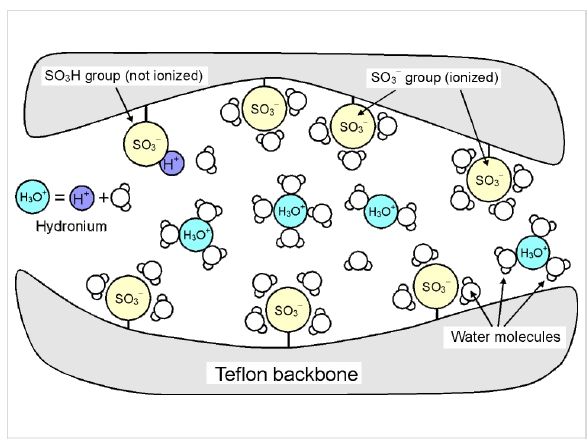
Figure 1: Illustration of the proton-conduction mechanisms of Nafion. Nafion polymer chains self-align into a micro channel structure. The sulfonic acid functional groups along the channel wall enable hydro- nium conduction.